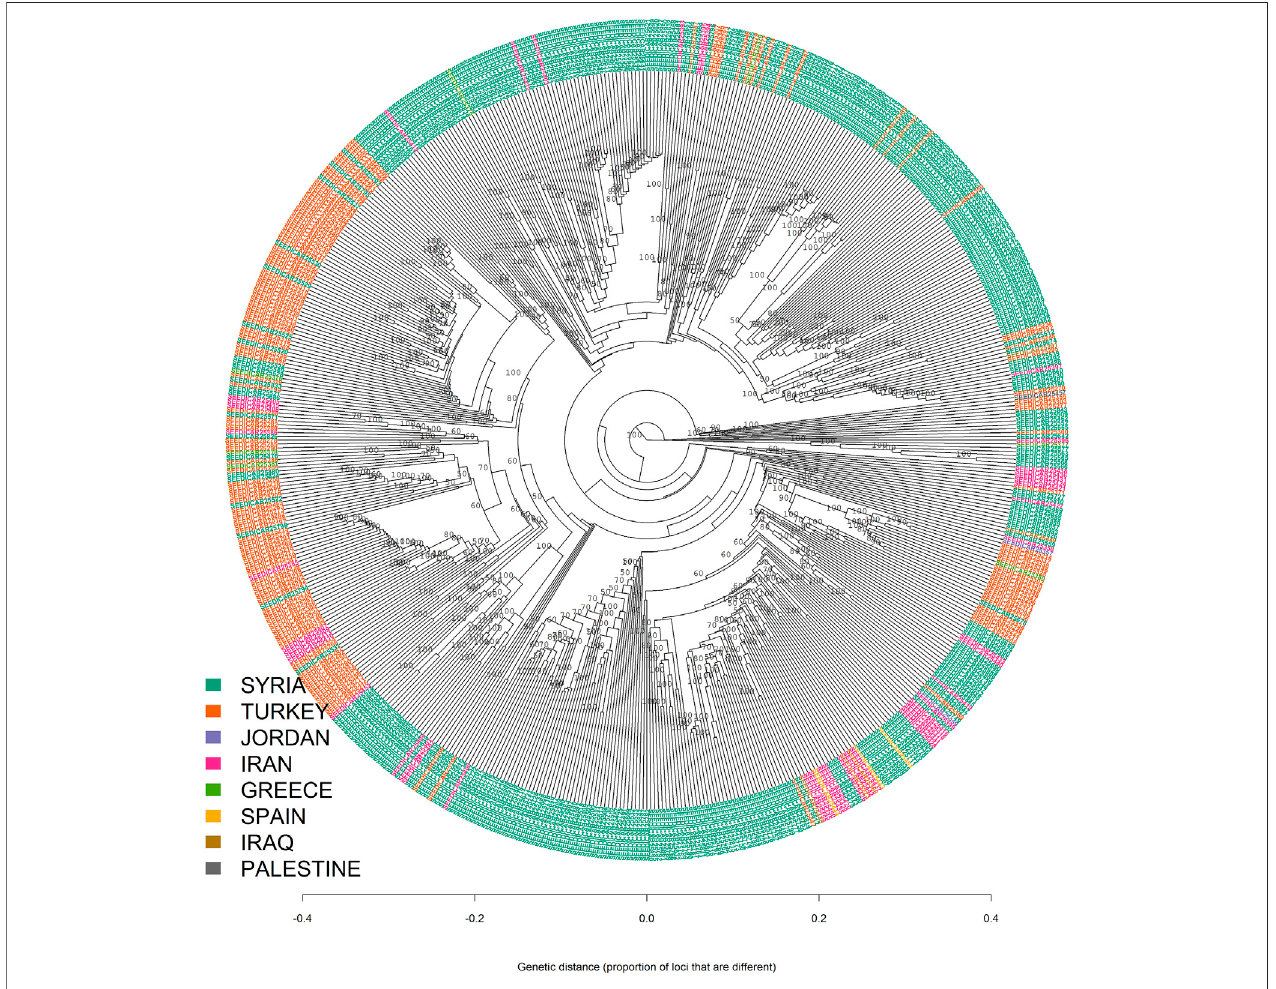
FIGURE 5 | Neighbor-joining clustering of 600 bread wheat landraces.